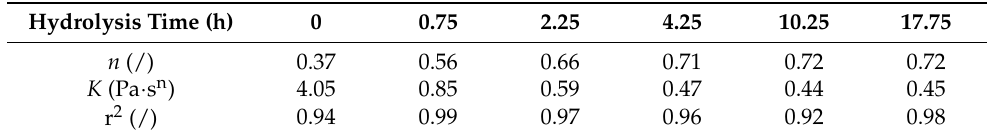
Table 4. Evolution of power-law index during hydrolysis of CR500 suspension (20% dm, Stargen